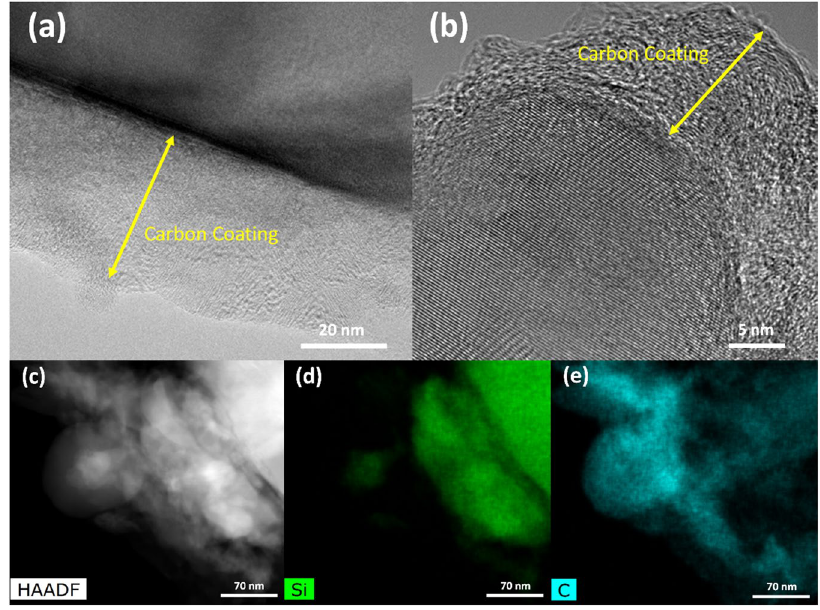
Figure 5. TEM images of gSi@C displaying the conformal carbon coating and the carbon layer thickness across gSi particles with ( a ) low magnification and ( b ) high magnification. ( c ) STEM-HAADF image of carbon coated gSi particles. ( d , e ) EDS mapping showing the phase conformal carbon coating surrounding